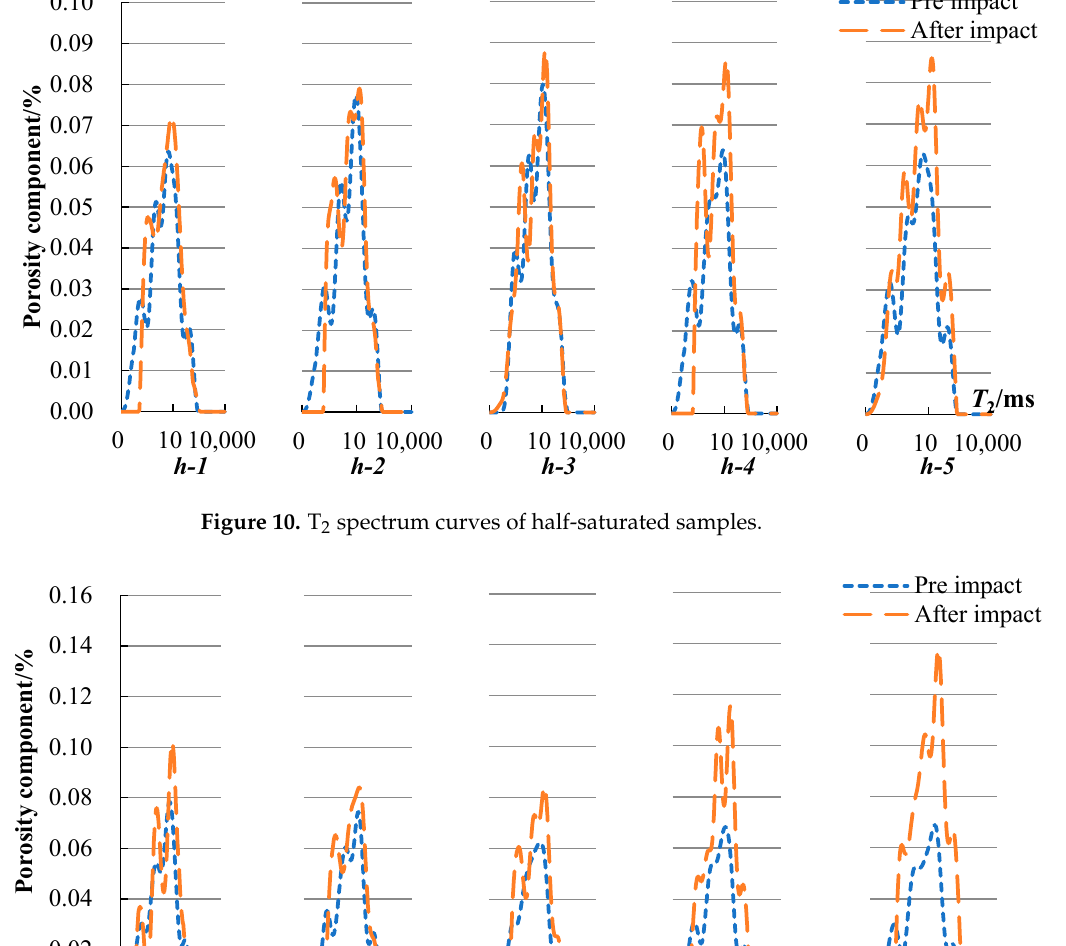
Figure 9. T 2 spectrum curves of dry samples.